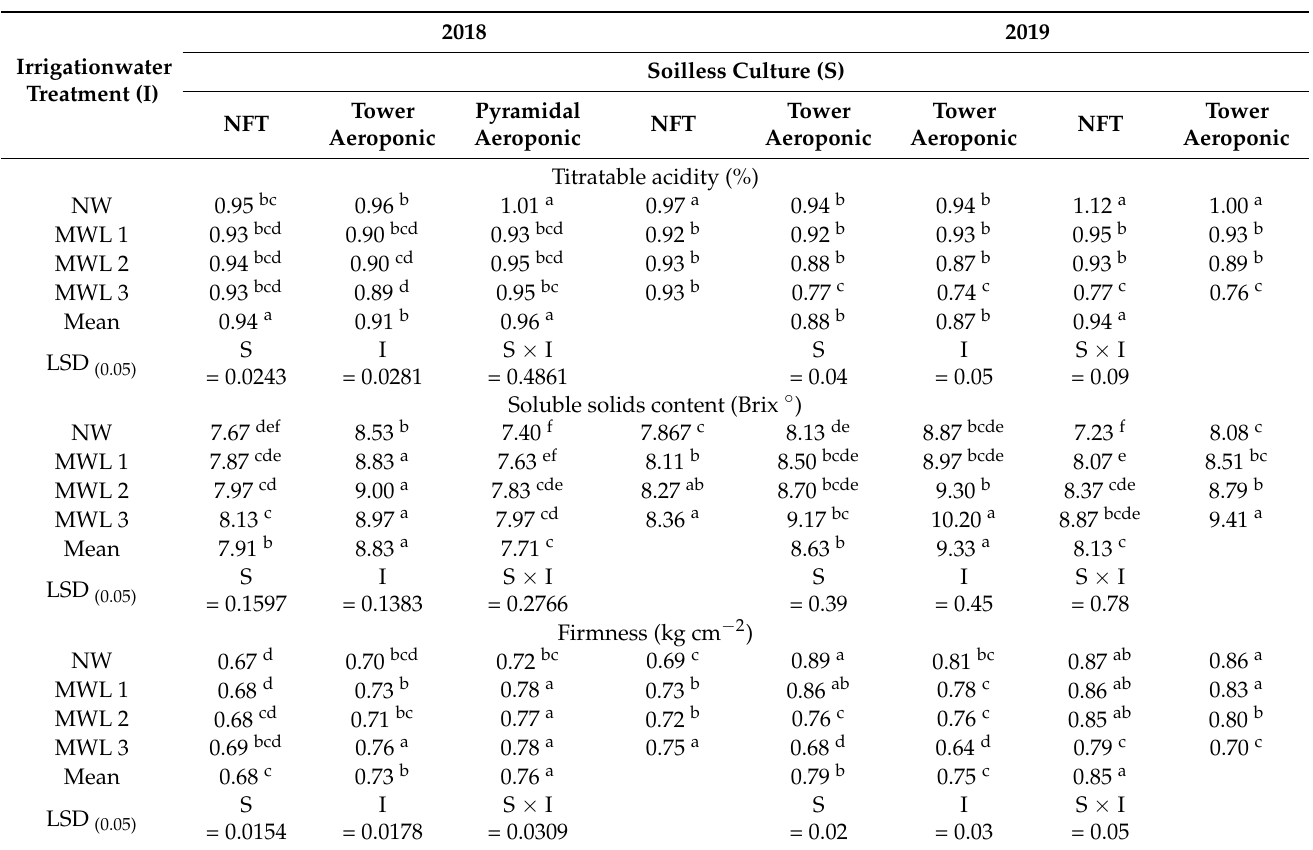
Table 5. The influence of soilless culture systems, irrigation water magnetic treatments and their interaction on titratable acidity (TA), soluble solids content (SSC), and firmness of strawberry fruits. Mean values are